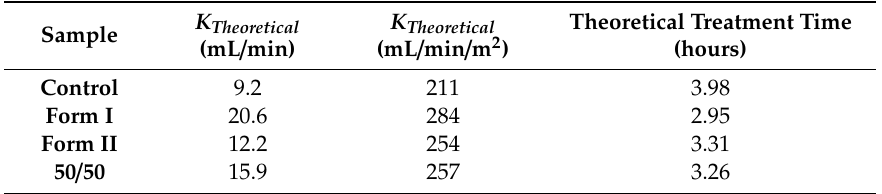
Table 3. Theoretical urea clearance and treatment times for dialysis using di ff erent membrane variations. K Theoretical K Theoretical Theoretical Treatment Time Sample (mL / min) (mL / min / m 2 )